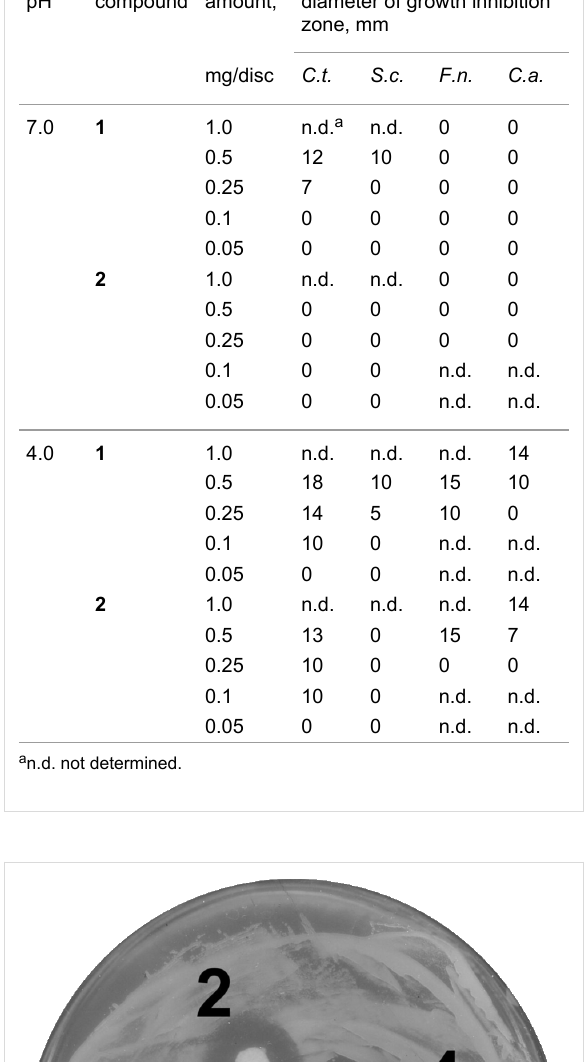
Table 7: Growth inhibition zones (Figure 6) of C. terreus ( C.t. ), S. cere- visiae ( S.c. ), F. neoformans ( F.n. ) and C. albicans ( C.a. ) in the pres- ence of compounds 1 and 2 at pH 7.0 and 4.0.